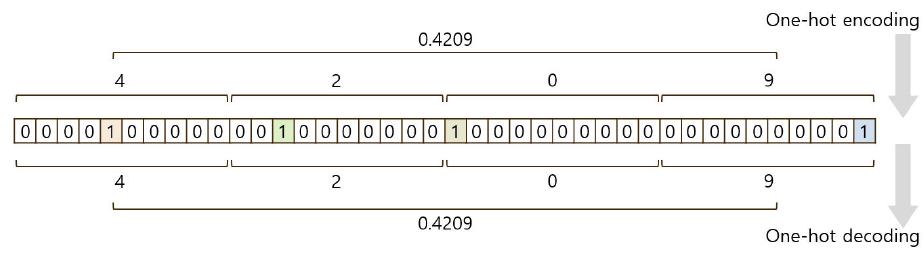
Figure 6. One hot encoding/decoding of vertex feature.